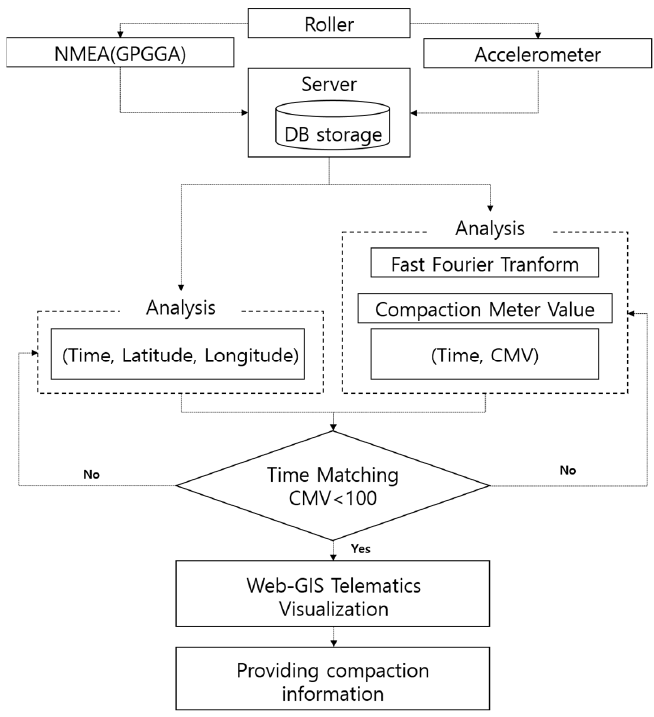
Figure 3. Design of the system software algorithm for compaction information.